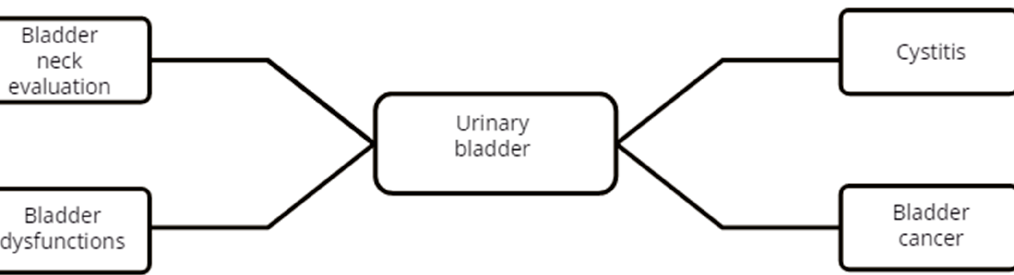
Figure 8. Urinary bladder pathologies assessed by elastography.